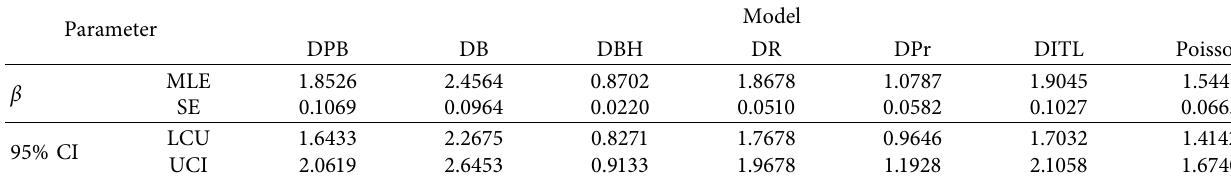
Figure 7: Data set III visualizations. Table 13: Te MLE, SE, and CI of the tested models based on data set